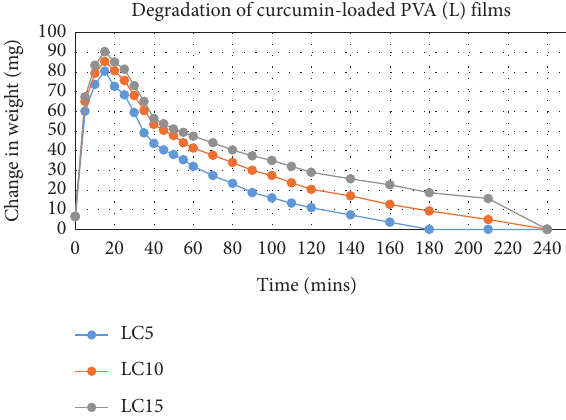
Figure 3: Degradation of curcumin-loaded PVA (L) films.